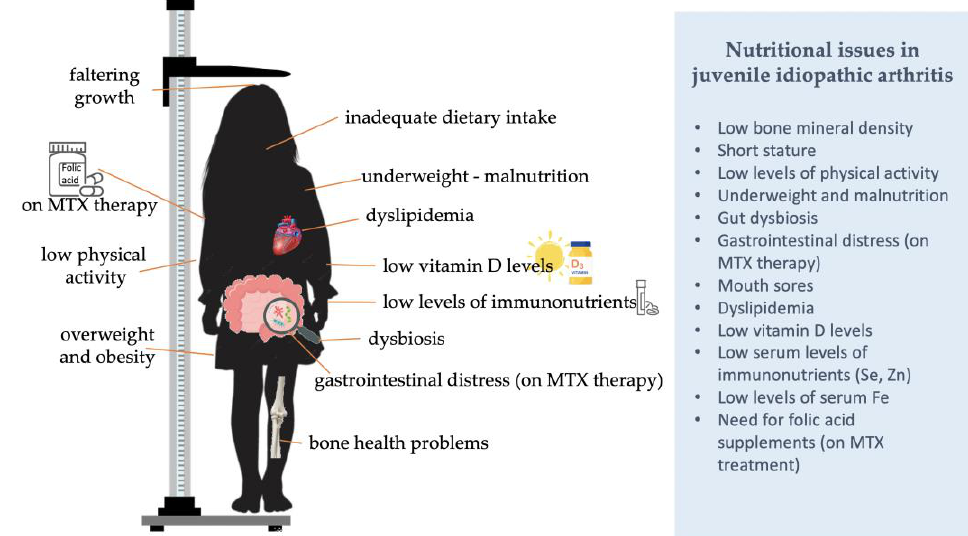
Figure 1. Common nutritional issues in children and adolescents with JIA.